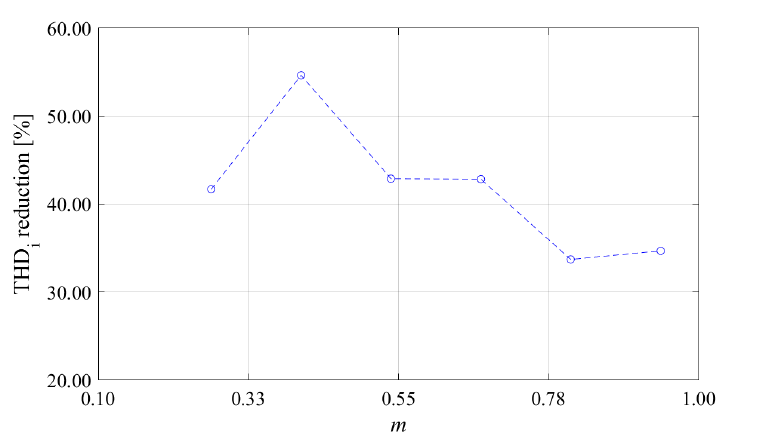
Figure 10. Reduction of the THD i achieved by means of the proposed modulation technique with respect to the traditional for different values of the modulation index, m